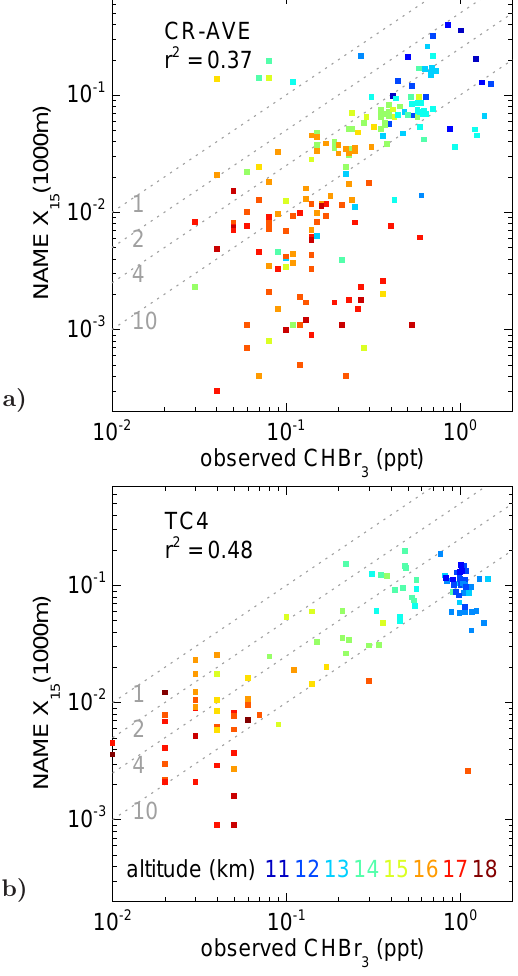
TC4 d ) Fig. 9. TTL tracer fraction (i.e. assuming a boundary layer concentration of 1) calculated from NAME back trajectories corresponding to the measurements presented in figure 8 for CR-AVE (a and b) and TC4 (c and d). The tracer is initialised at 1 km agl. In a and c (b and d) the tracer has an e-folding lifetime of 15 (5) days. The solid black lines show the mean ± 1 standard deviation in each 1 km altitude bin. Note that the horizontal scales are not all the same.